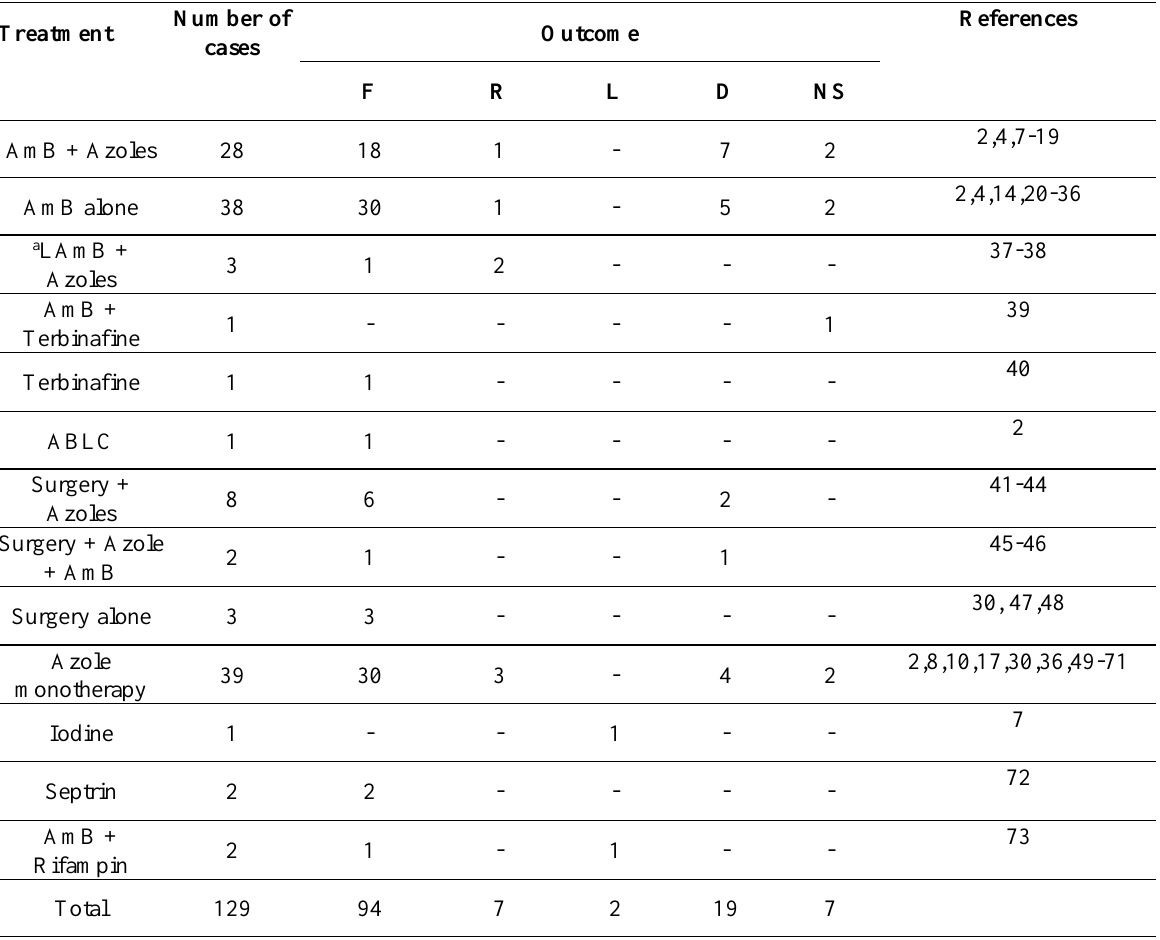
Table 1. Summary of treatment and